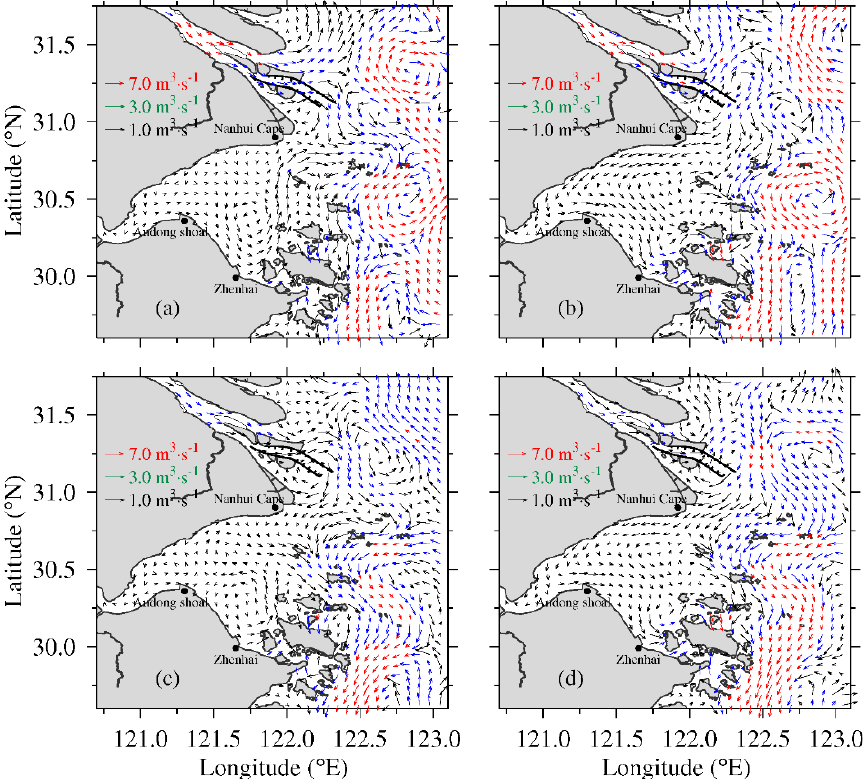
Figure 10. Distribution of the RUWF in the whole layer during neap tide (left panel) and spring tide (right panel) in summer ( a , b ) and winter ( c , d ).